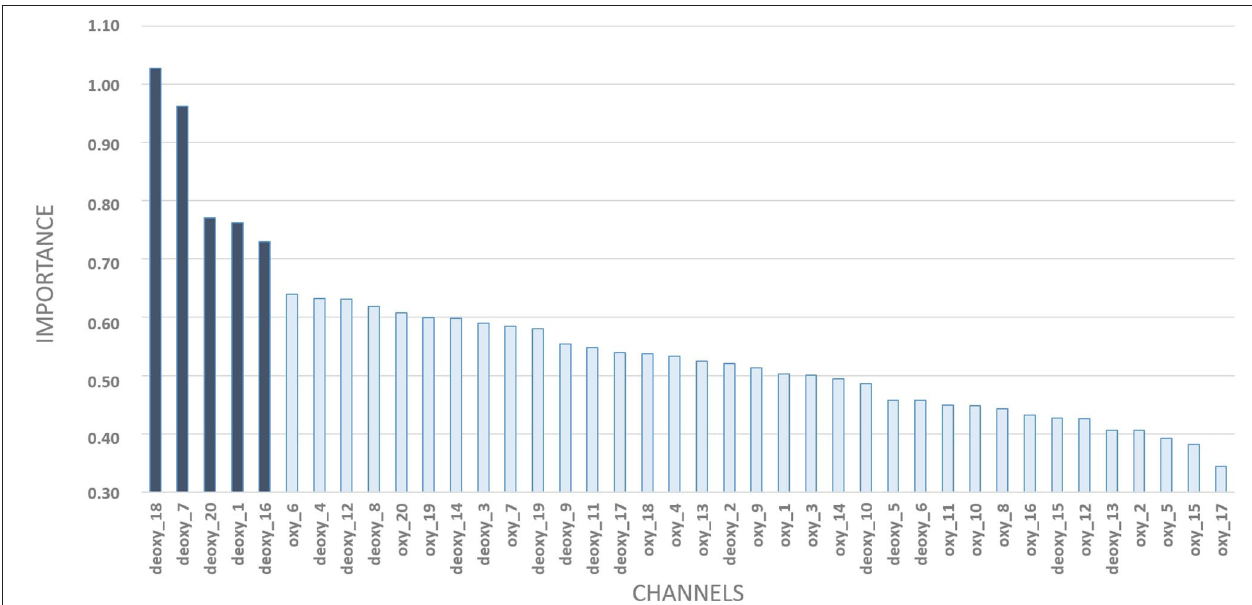
FIGURE 6 | Random forest outputs: level of importance of each covariate with a detailed zoom at the top-5 ones.